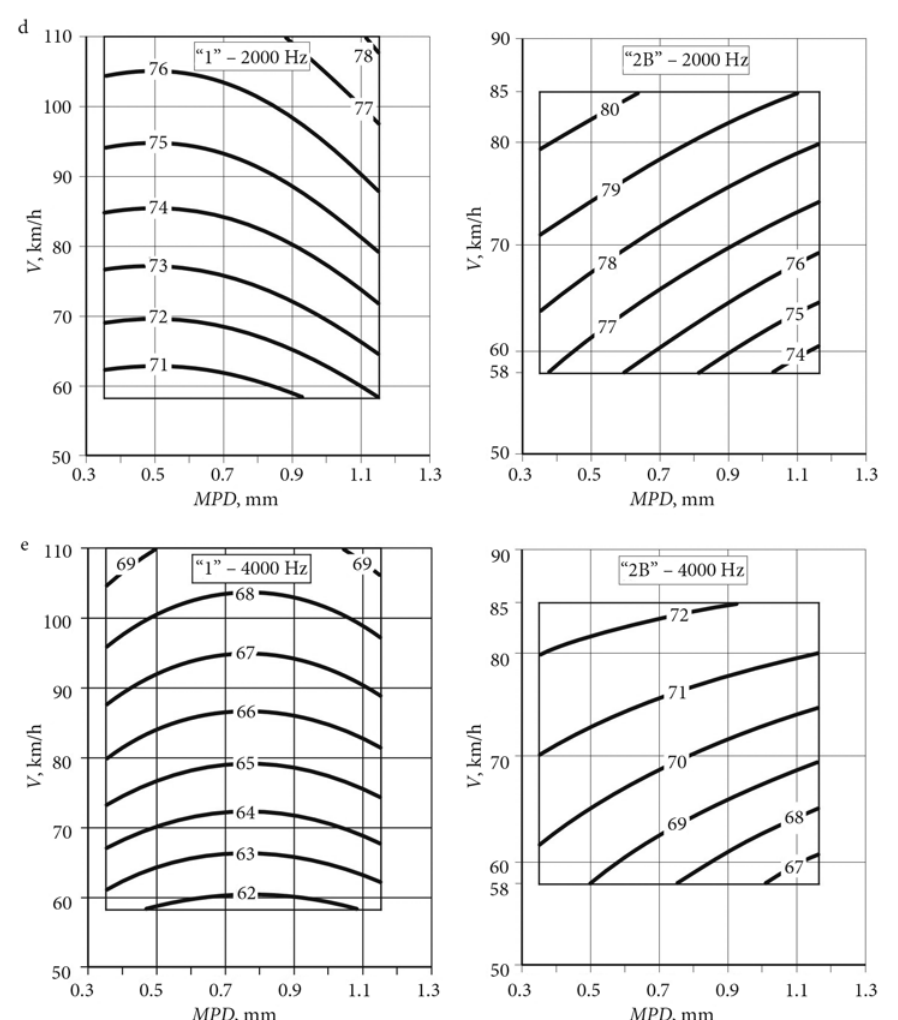
Fig. 7. Noise level in the octave band spectra as a function of MPD and speed of passenger car (category „1”) and heavy